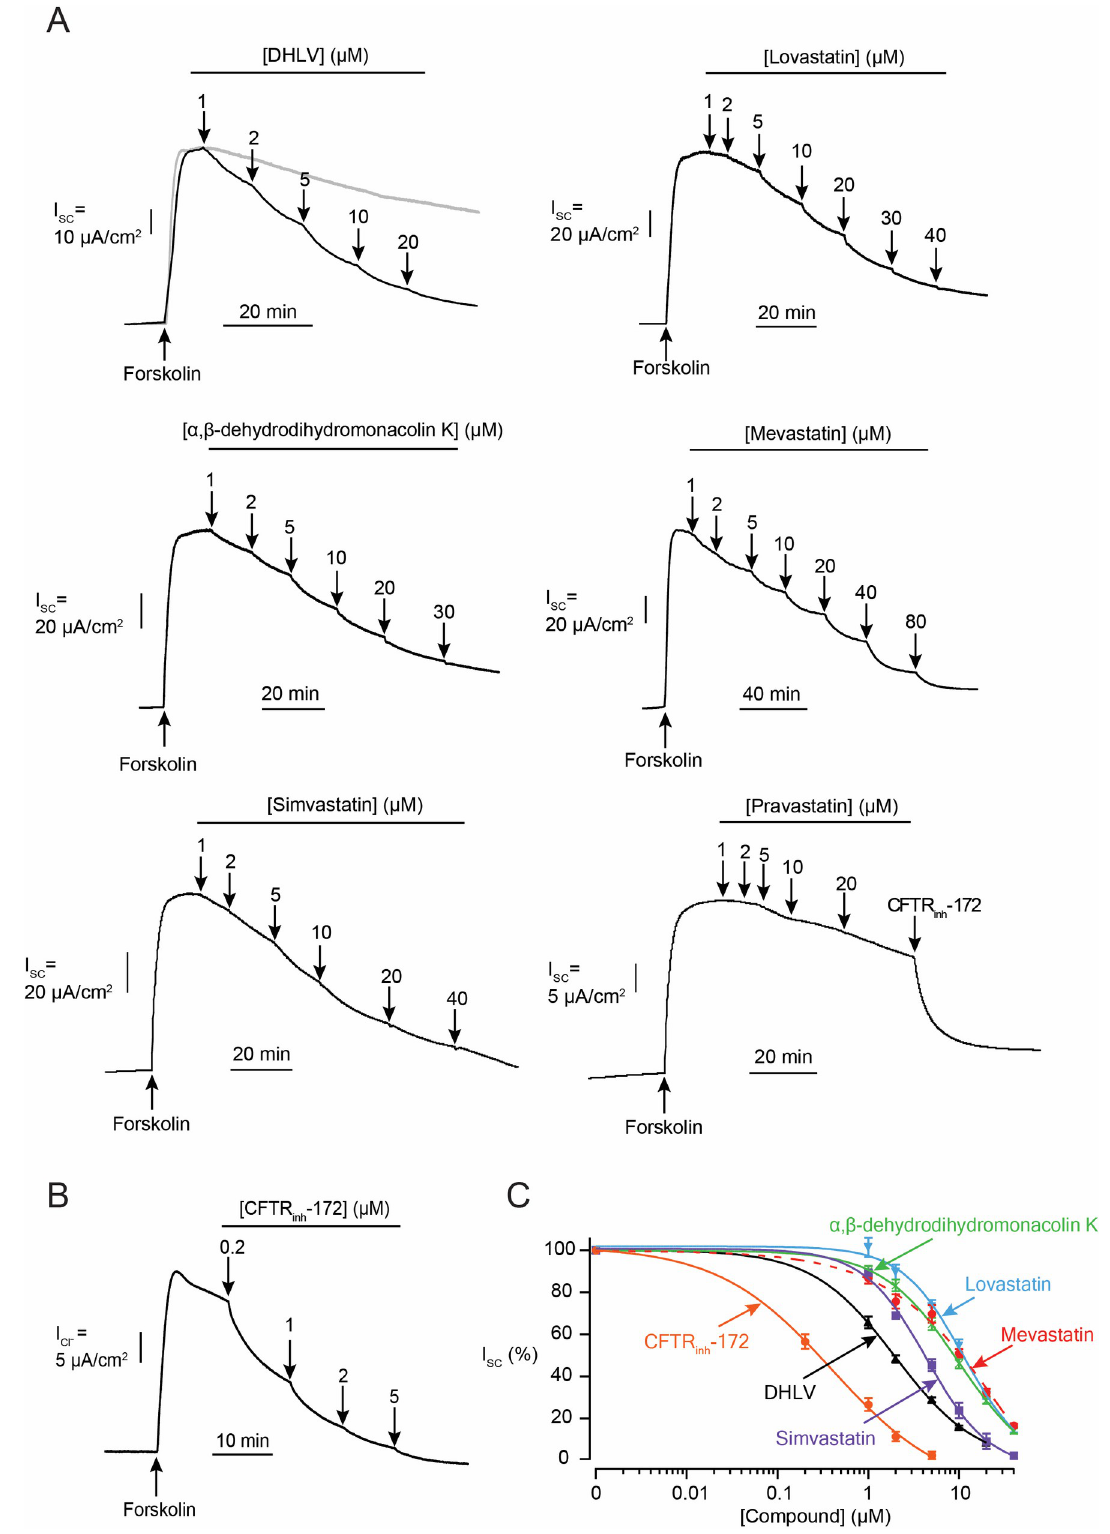
Fig 2. Effect of statin derivatives isolated from soil fungus Aspergillus sclerotiorum and statin drugs on cAMP-dependent Cl - secretion in T84 cell monolayers. (A) Effect of α , β -dehydrolovastatin (DHLV), lovastatin, α , β -dehydrodihydromonacolin